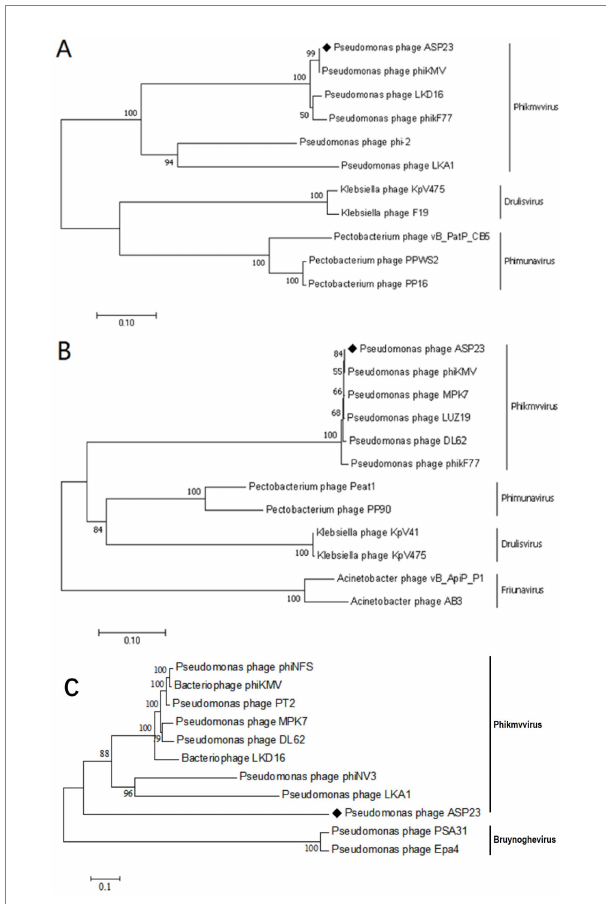
FIGURE 4 Neighbor-joining phylogenetic trees for the amino acid sequences of (A) Major capsid protein (B) DNA polymerase and (C) Whole genome sequence showing the evolutionary relationships between phage ASP23 and other known phages.